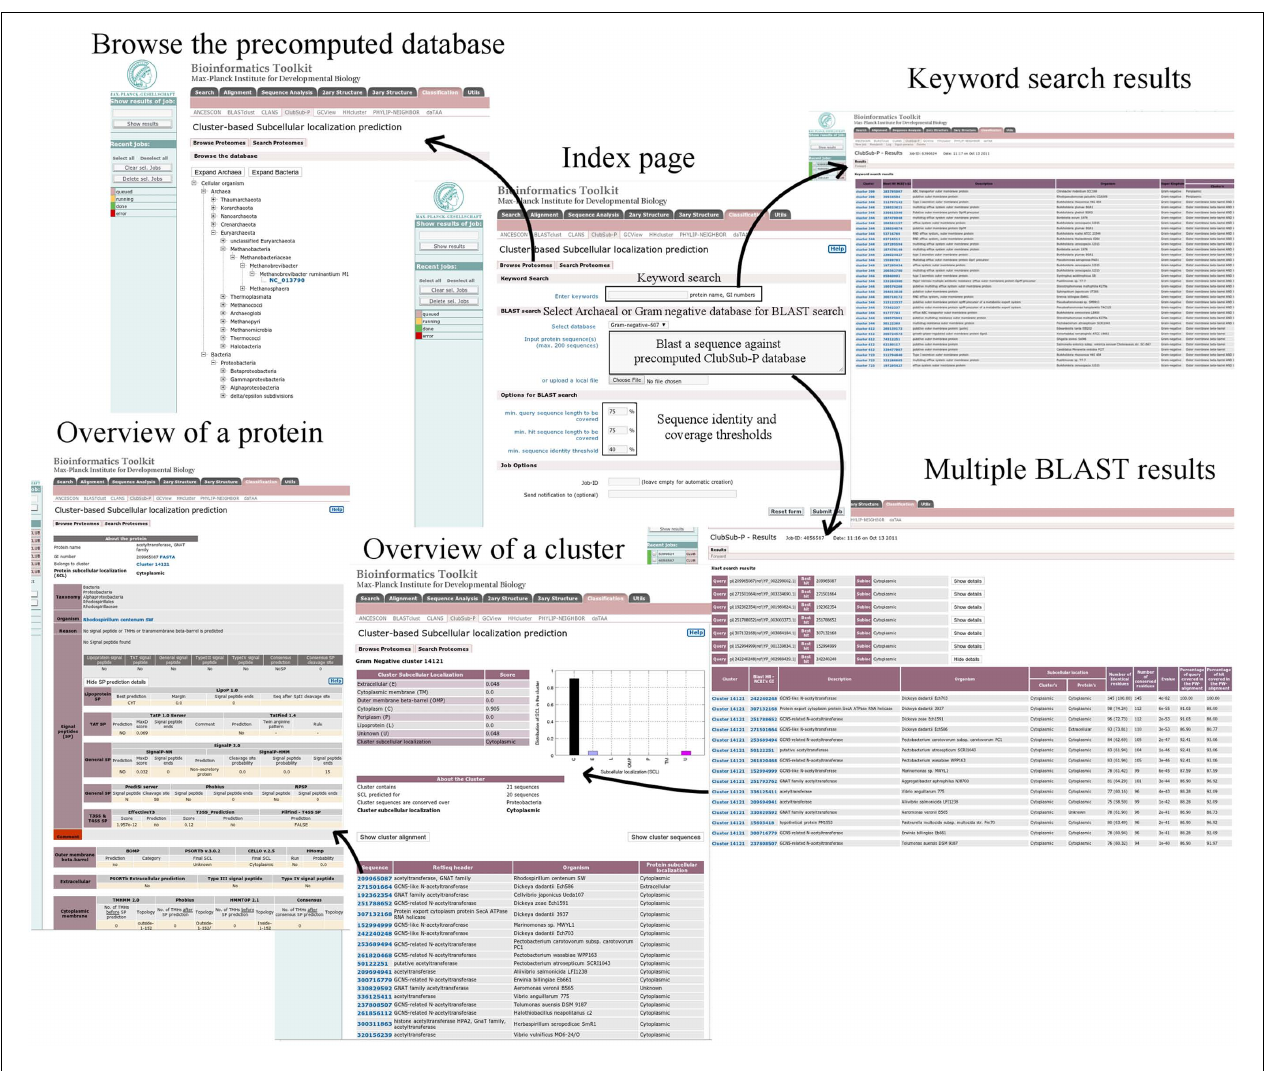
FIGURE 6 | ClubSub-P database